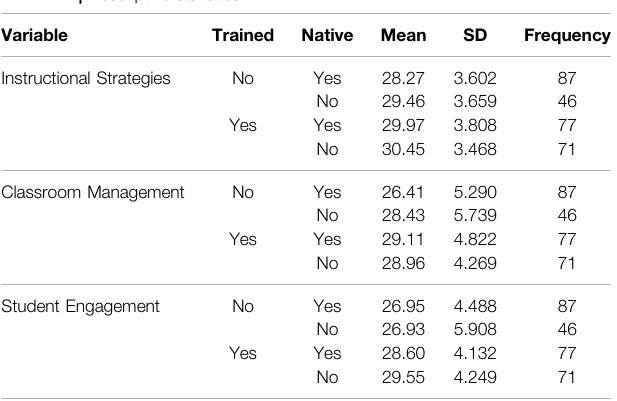
TABLE 4 | Descriptive statistics.